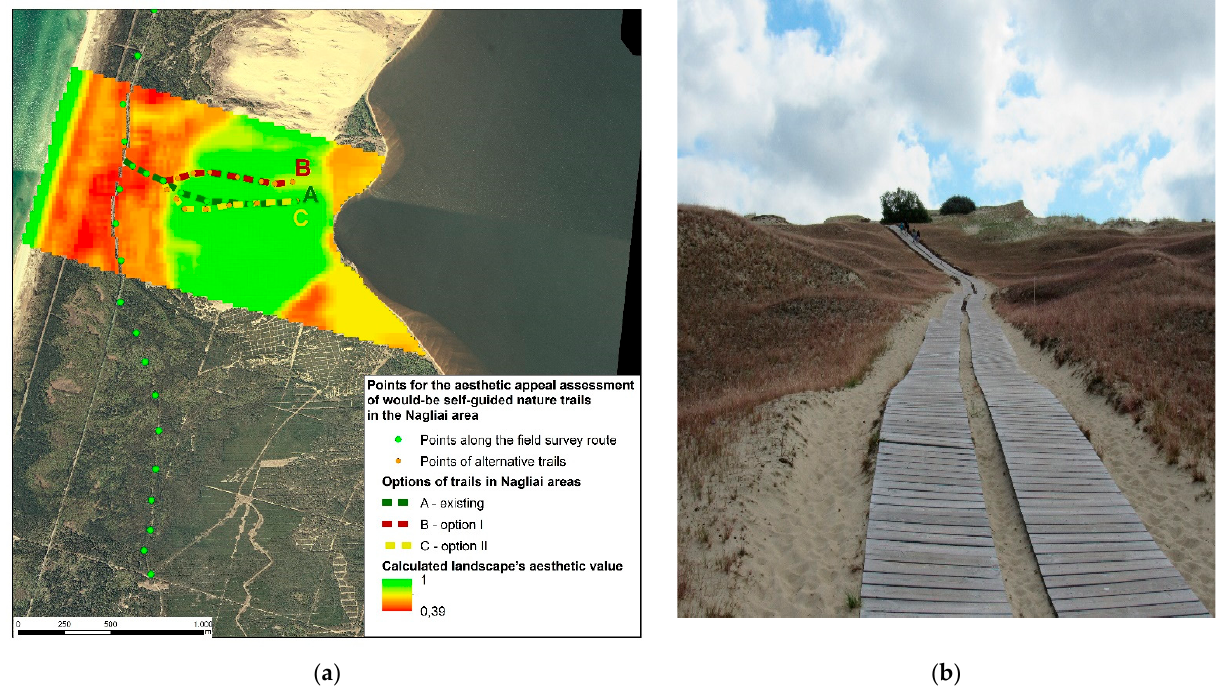
Figure 14. The scenic quality of the surrounding landscape of a self ‐ guided nature trail in Nagliai Strict Nature Reserve.: ( a ) Three planned alternatives and the scenic quality of their surrounding landscape; ( b ) The self ‐ guided nature trail in Nagliai Strict Nature Reserve (providing the only access for the visitors to the strict nature reserve). (Map and photo by Arvydas Urbis).